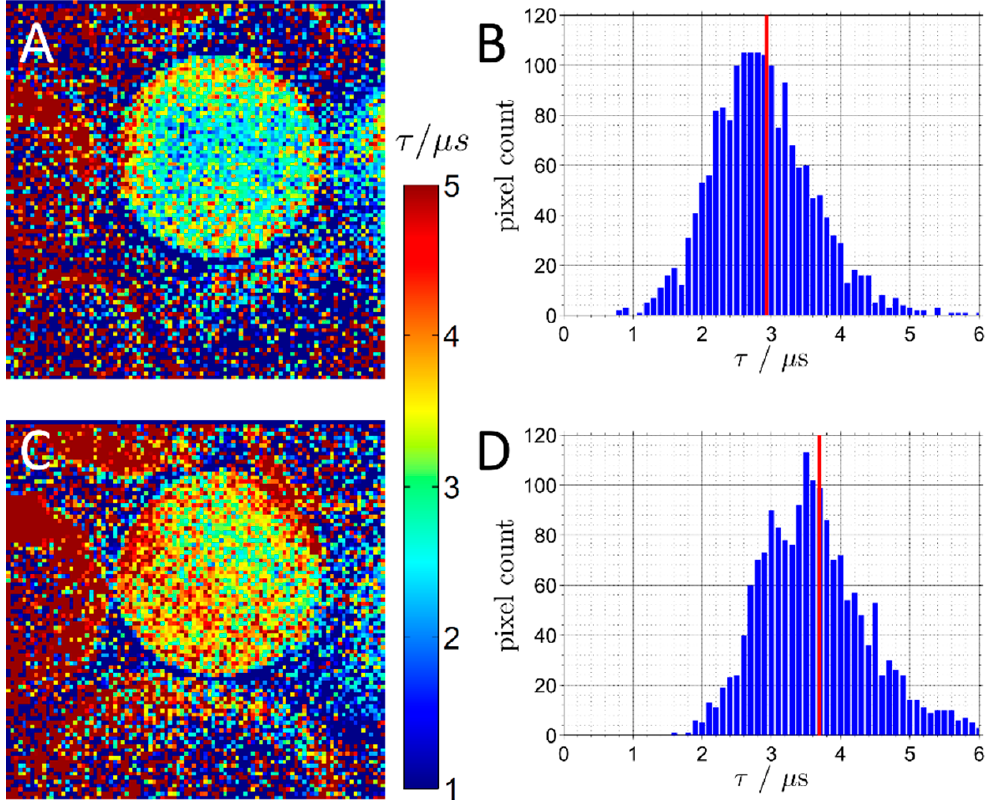
Figure 9. Luminescence lifetime images of beads with immobilized enzyme and Ru(dpp) 3 . Panels show imaging results under flow with ( C , D ) and without ( A , B ) substrate, resulting in different oxygen concentrations. ( B , D ) Pixel lifetime distributions of the beads are shown in ( A ) and ( C ), with the mean values marked by red lines. Adapted with permission from reference [64]. Copyright (2016) American Chemical Society.